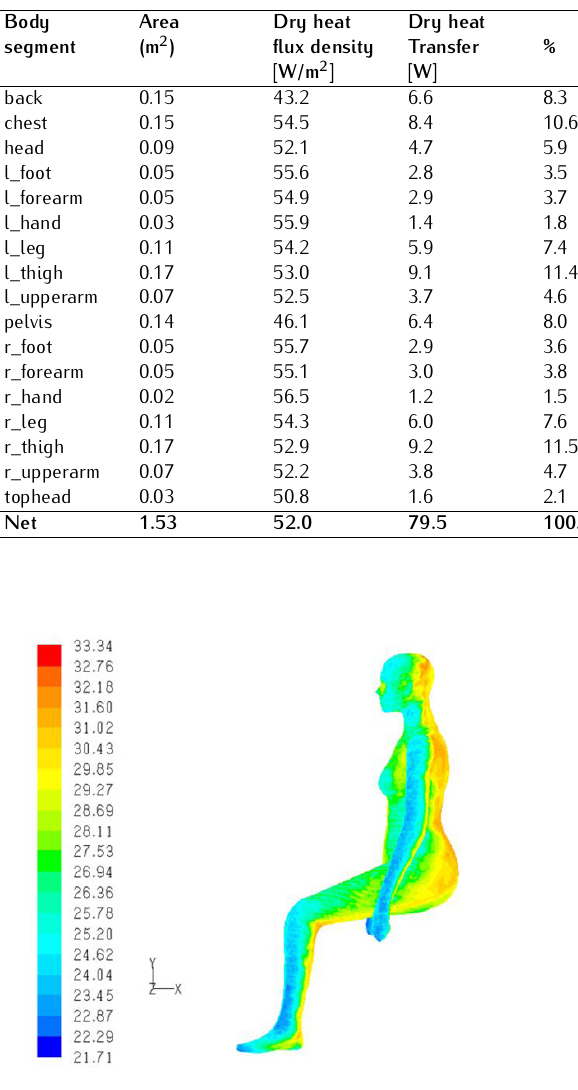
clothing characteristics and the water vapour potential between skin and room air. Highly humid air can drastically reduce the maximum available latent heat loss and the ability to cool the body via sweating, leading to increased skin weteddness and sensation of discomfort even at relatively low temperatures (22-25 ◦ C). This may often be experienced at equatorial and tropical regions, or even after precipitations in spring or summer. Finally, the distribution of humidity released from the